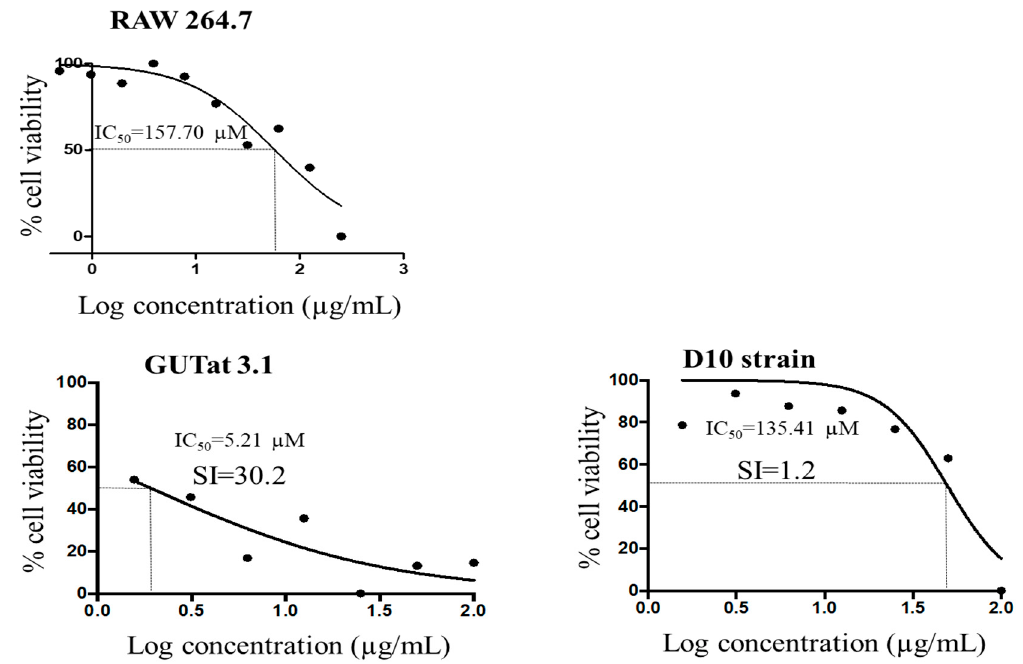
Figure 5. Dose-response curves for compound 1 : Half-maximal inhibitory concentration (IC 50 ) values were calculated from cell viability analysis in T. brucei subsp. brucei (GUTat 3.1), Leishmania donovani (Laveran and Mesnil) Ross (D10) and mouse macrophages (RAW 264.7). Selectivity indices (SI = 30.2,